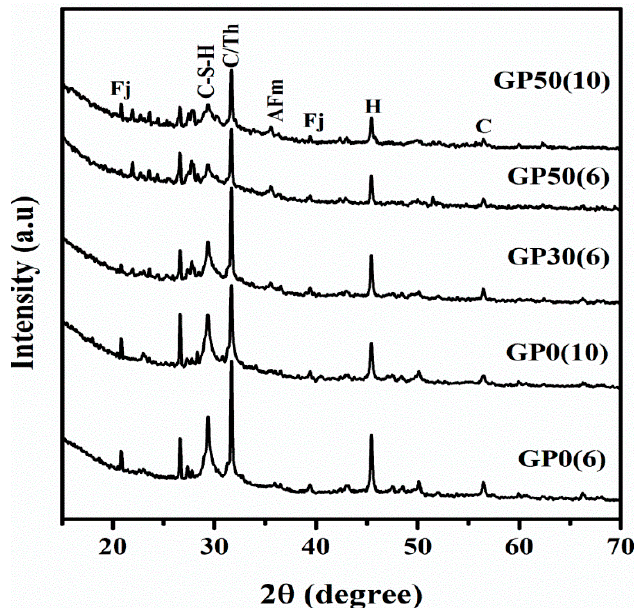
Figure 4. X-ray diffractogram of Geopolymer cement without and with VA (C-S-H = Calcium silicate hydrate, C = Calcite, Th = Thernadite, Fj = Faujasite-Na, AFm = Hydrocalcumite and H= Halite).